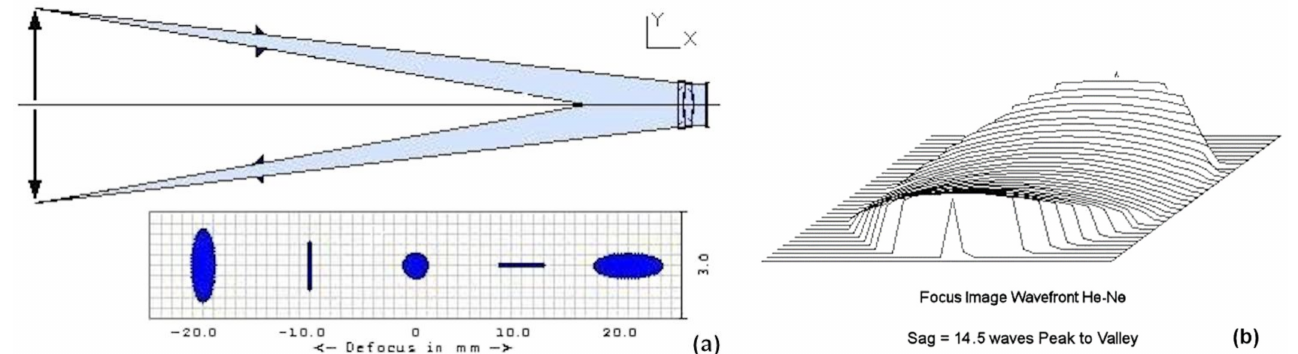
Figure 4. Finite distance mounting with a flat mirror 30-mm circular clear aperture and an achromatic lens passed twice through. This mounting ( a ) provides an equivalent astigmatism sag amount ( b ) than that of the